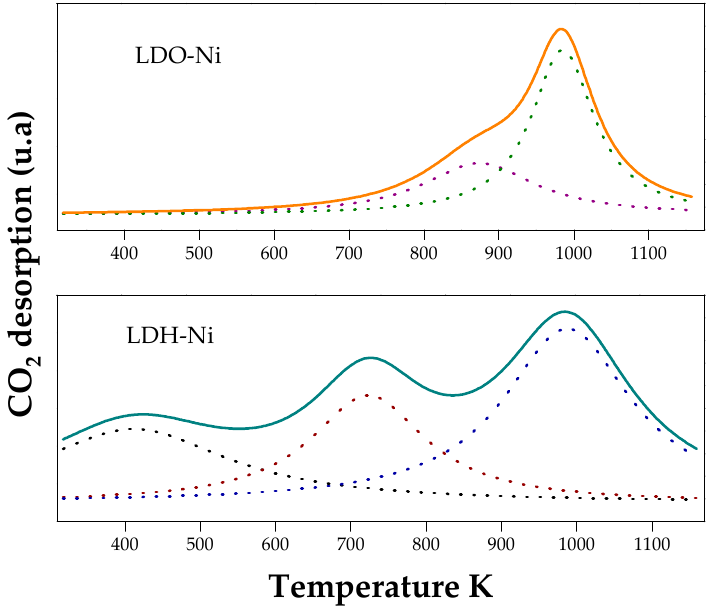
Figure 7. Analysis of CO 2 desorption of LDH–Ni and LDO–Ni.